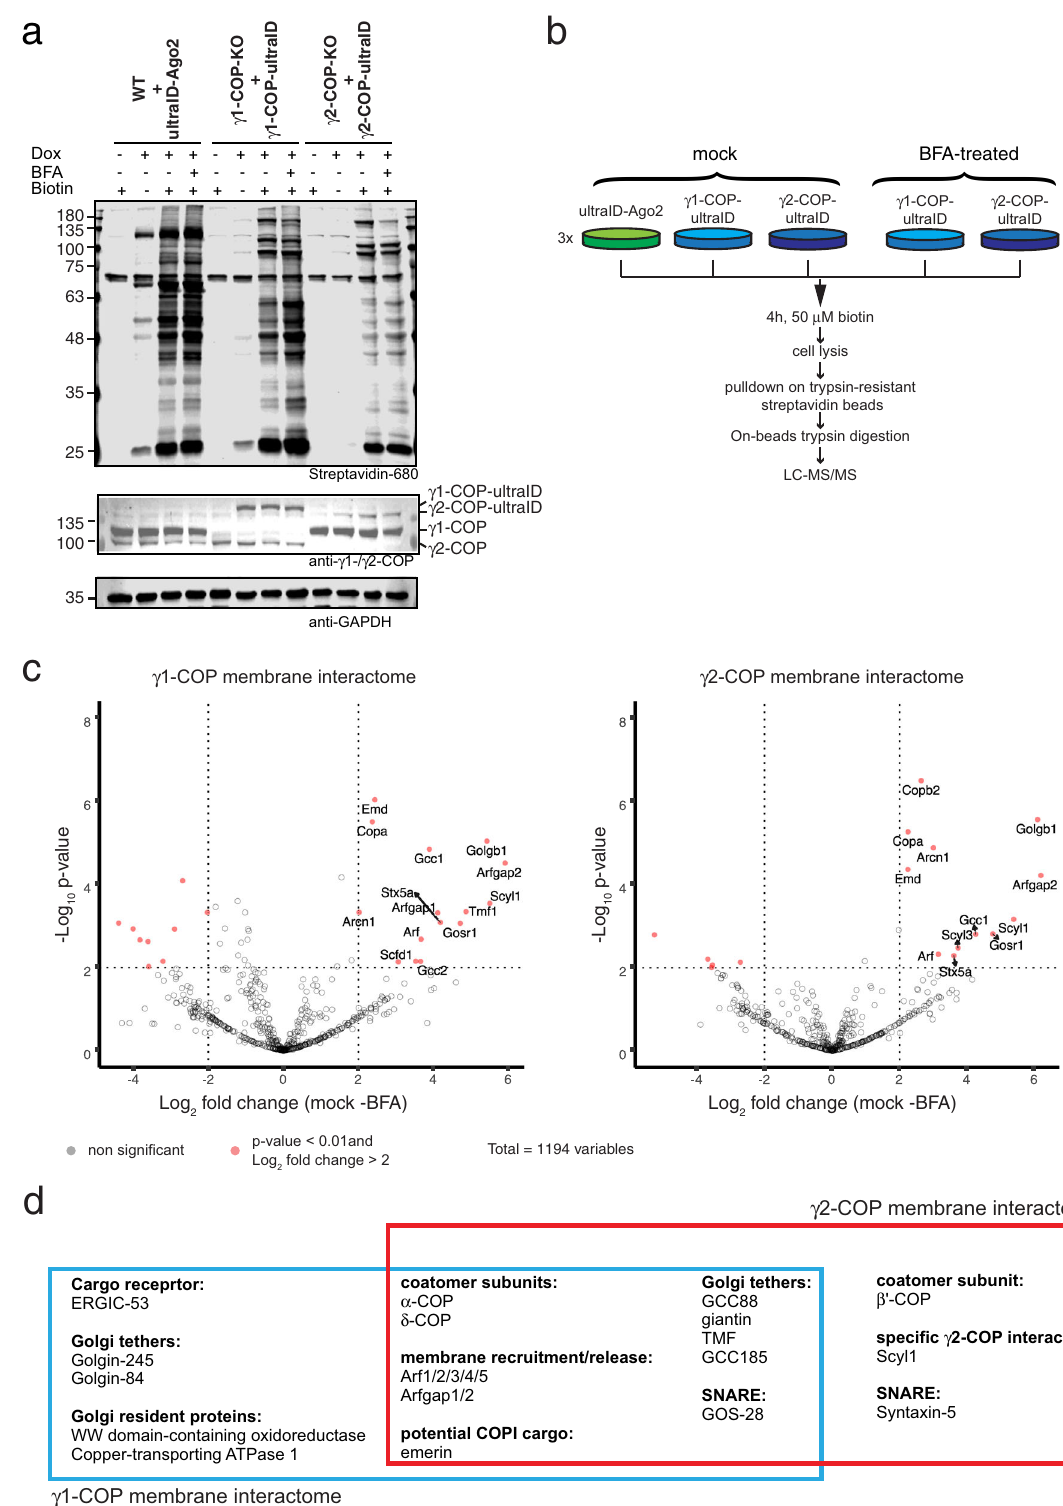
Fig. 8 Probing a membrane-associated interactome with ultraID. a Blots of lysates of P19 cells stably expressing ultraID-Ago2, of P19 cells knock-out for endogenous γ 1-COP and rescued by γ 1-COP-ultraID, and of P19 cells knock-out for γ 2-COP and rescued by γ 2-COP-ultraID lines. The fusion proteins were detected with antibodies against γ 1- and γ 2-COP and biotinylation with IRDye680-labeled streptavidin. b Experimental set-up for the determination of the membrane-associated interactome of γ 1-COP and γ 2-COP. c Volcano plots of the proteins identi fi ed by LC-MS/MS with the mock vs. BFA samples. Signi fi cant hits ( p value <0.01 and log 2 fold change >2 in this analysis, and p value <0.01 and log 2 fold change >2 in the γ -COP vs. Ago2 comparison under mock conditions), are indicated with gene names in red. d Proteins identi fi ed as membrane interactors of γ 1-COP and γ 2-COP (see